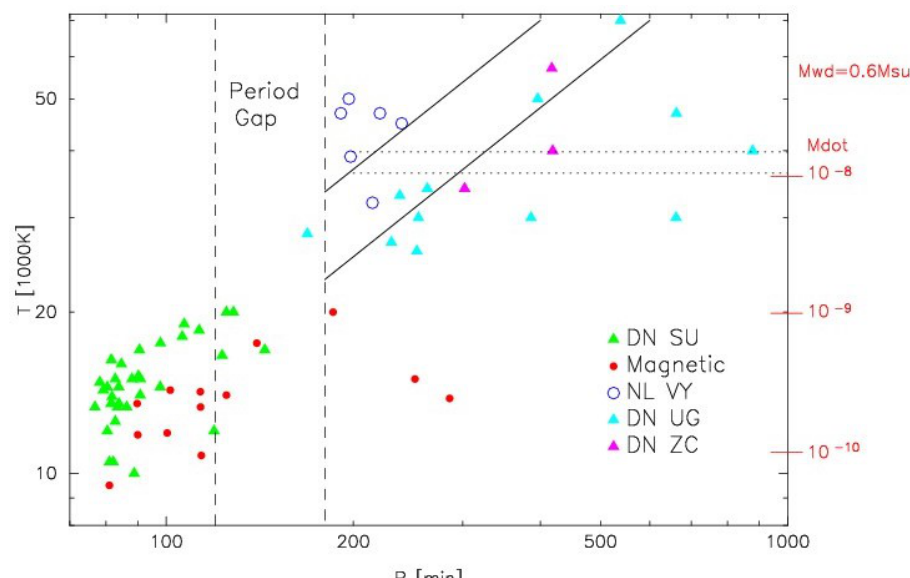
Figure 2: Effective White Dwarf Temperature as a function of the orbital period. The references for the indivdual temperatures can be found in Sion et al. 2008, Townsley & G¨ansicke 2009, Araujo-Betancor 2005a & b and references therein). The traditional magnetic braking above the period gap is shown between the parallel diagonal solid lines. On the right hand side are the time-averaged accretion rates correpsonding to the temperature scale on the left hand side of the diagram. Shown for comparison between the dotted lines is the long term evolutionary path of a 0.8 solar mass white dwarf (with an initial core temperature of 30 million degrees K) which has undergone 1000 nova outburst cycles accreting at the long term rate of 10 − 8 M (cid:12) /yr